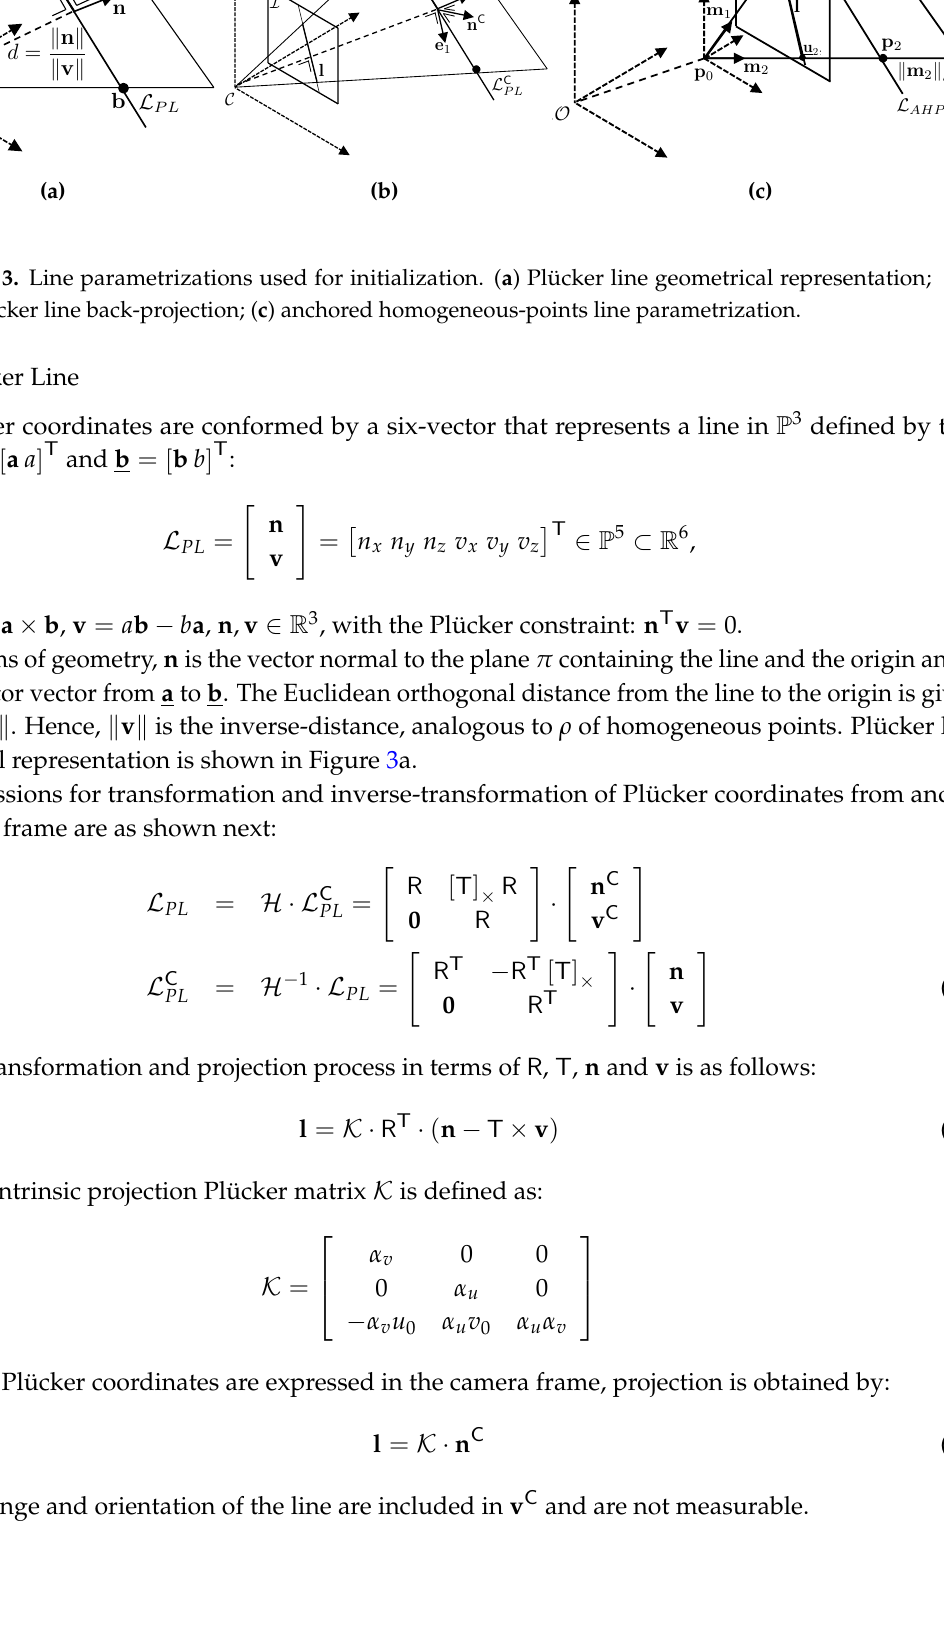
Figure 2: Pl¨ucker line geometrical representation. Image extracted from [ ? ]